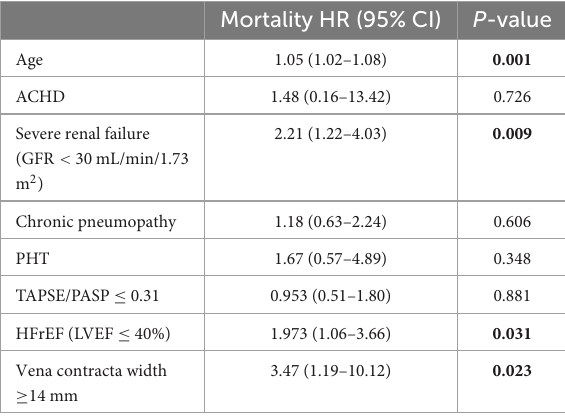
TABLE 3 Characteristics of surviving and deceased patients at 2 years. TABLE 4 Predictors of 2-year mortality: Multivariate